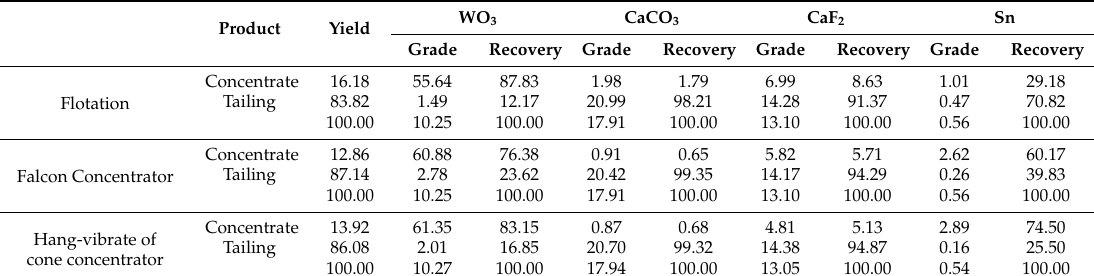
Table 5. Results of cleaning process using flotation and gravity separation by Falcon concentrator or hang and vibrate of cone concentrator.